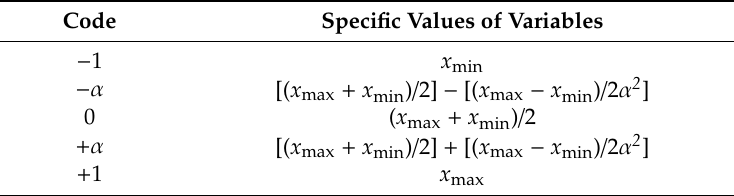
Table 6. The codes for specific values of individual variables.